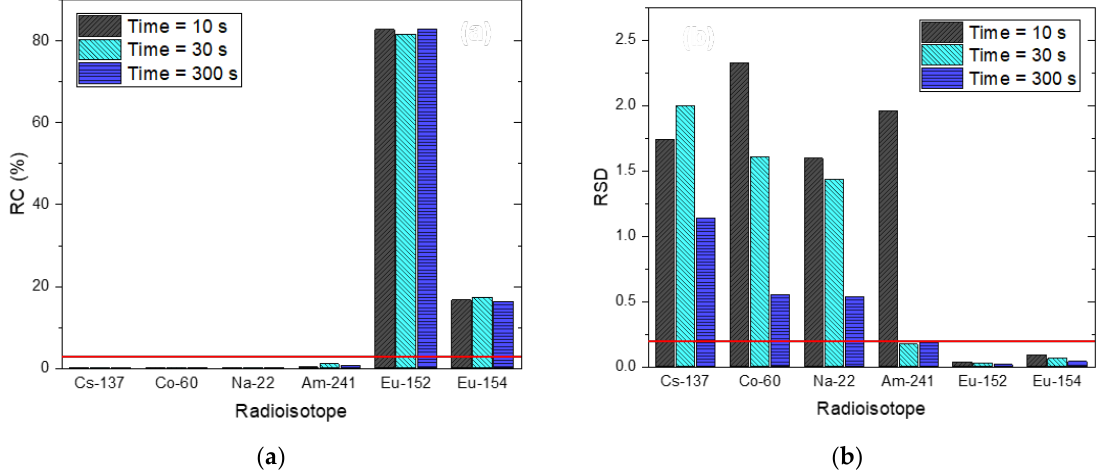
Figure 7. ( a ) RC and ( b ) RSD of radioisotopes in the radioisotope library for three spectra with acquisition times of 10 s, 30 s and 300 s with the following radioisotopes buried in sand: Eu-152, 3 cm and Eu-154, 6 cm. The red lines denote criteria for the RC and RSD (i.e., 3% and 0.2, respectively).